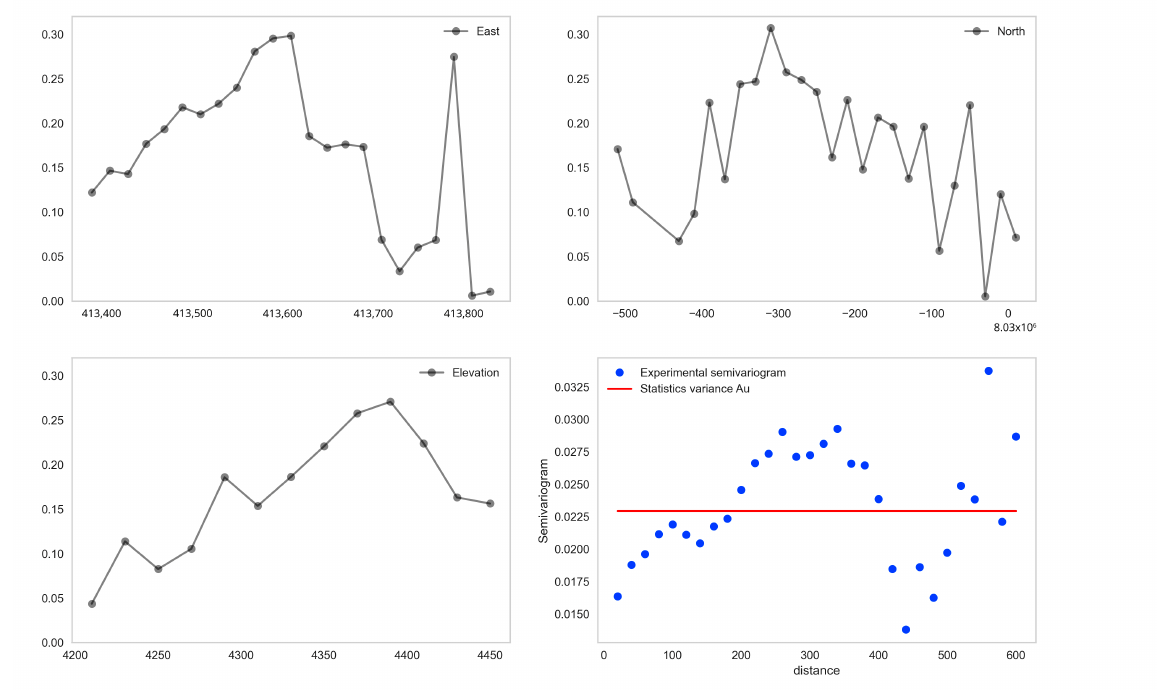
Figure 9. Drift and omnidirectional semivariogram domain